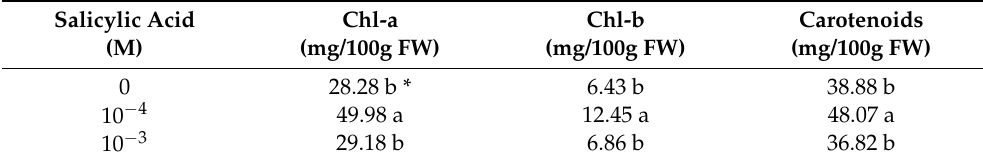
Table 4. Effect of different concentrations of salicylic acid on Chl-a, Chl-b, and carotenoids (mg/100 g FW) pigment contents of S. marianum